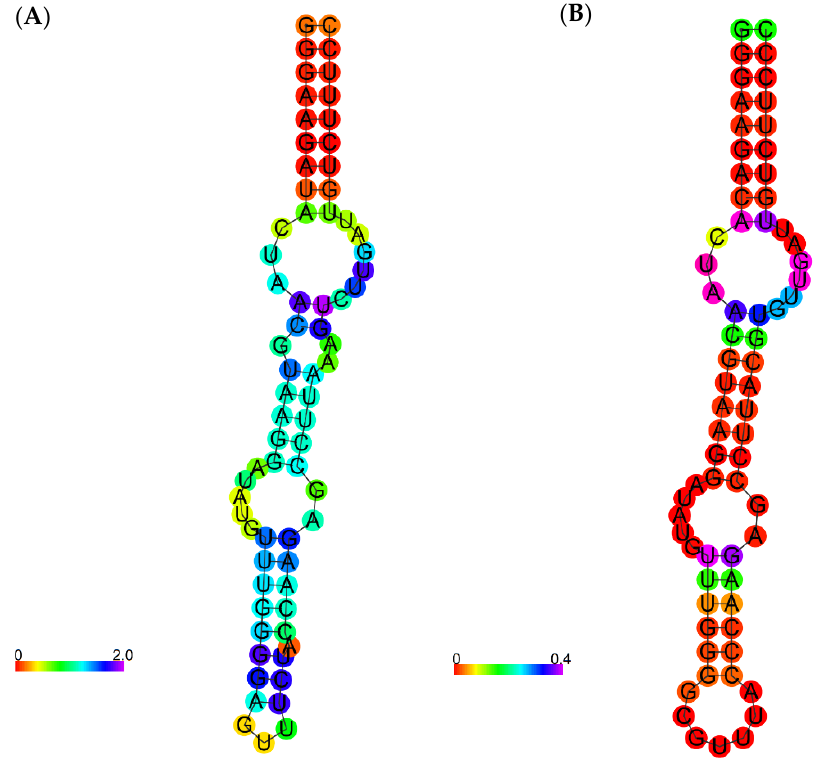
Figure 2. Secondary structures of ( A ) seq_09 aptamer and ( B ) the modified aptamer.